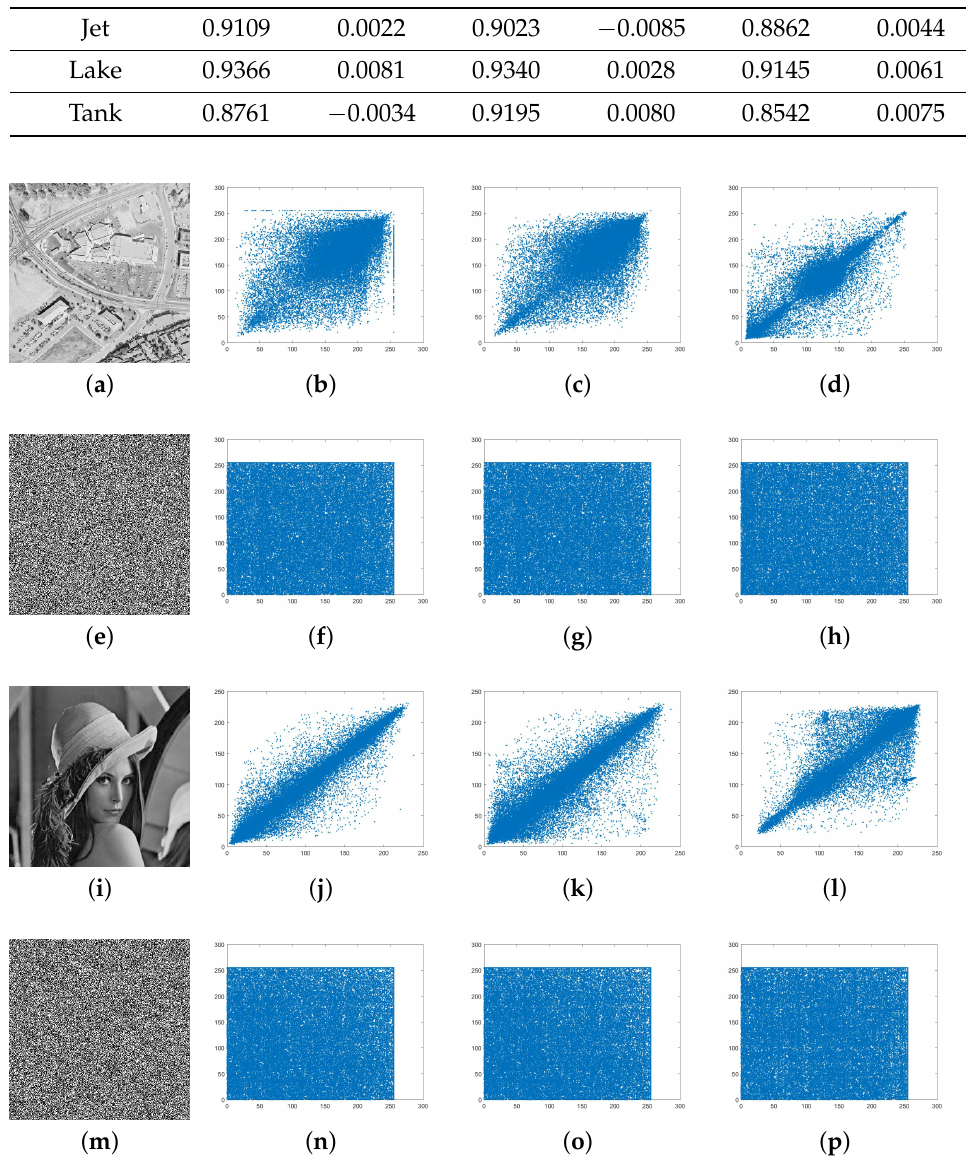
Figure 13. Correlation of neighboring pixels in plain and encrypted images: ( a ) aerial; ( b ) horizontal; ( c ) vertical; ( d ) diagonal; ( e ) encrypted aerial; ( f ) horizontal; ( g ) vertical; ( h ) diagonal; ( i ) lena; ( j ) horizontal; ( k ) vertical; ( l ) diagonal; ( m ) encrypted lena; ( n ) horizontal; ( o ) vertical; ( p ) diagonal. NPCR and UACI are two metrics used to assess the similarities between two images in pixel-level comparison and in terms of average intensity change [45]. The NPCR is used to calculate the number of pixels that differ between the two images, which is specified by Equation